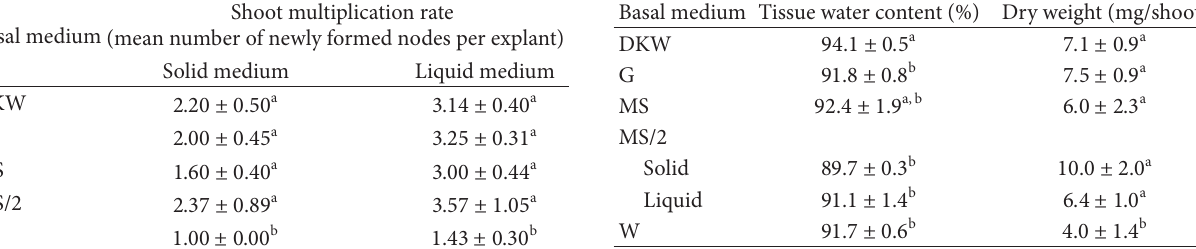
Table 1: Effect of basal media formulations on shoot multiplication of Cistus heterophyllus after 4 weeks of culture on agar-solidified media and liquid media.